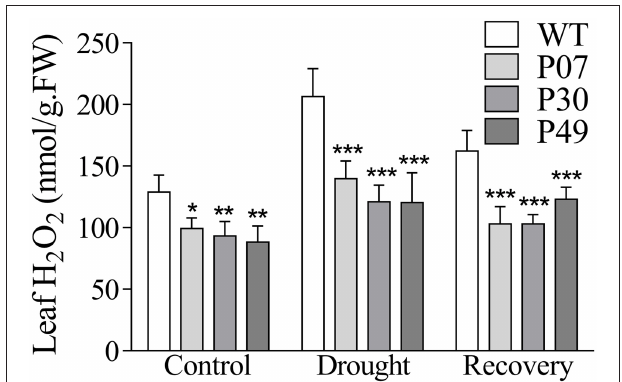
FIGURE 5 | Quantification of H 2 O 2 in leaves of WT and AtUCP1 transgenic tobacco plants. The first expanded leaf was collected from WT and transgenic plants under control ( D = 0), drought ( D = 15), and recovery ( D = 16) conditions. Bars represent the means of 5 plants ± SD. Bars with *, **, and *** differ significantly from the WT ( P < 0.1, P < 0.05, and P < 0.01,